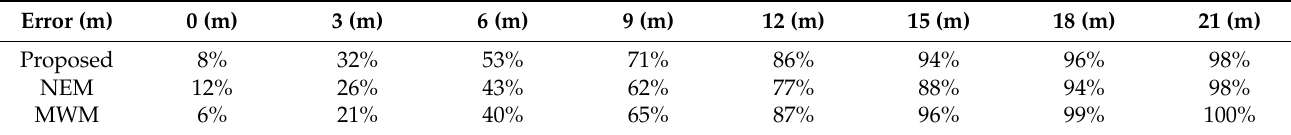
Table 13. KNN with NEM Simulated Test Samples.